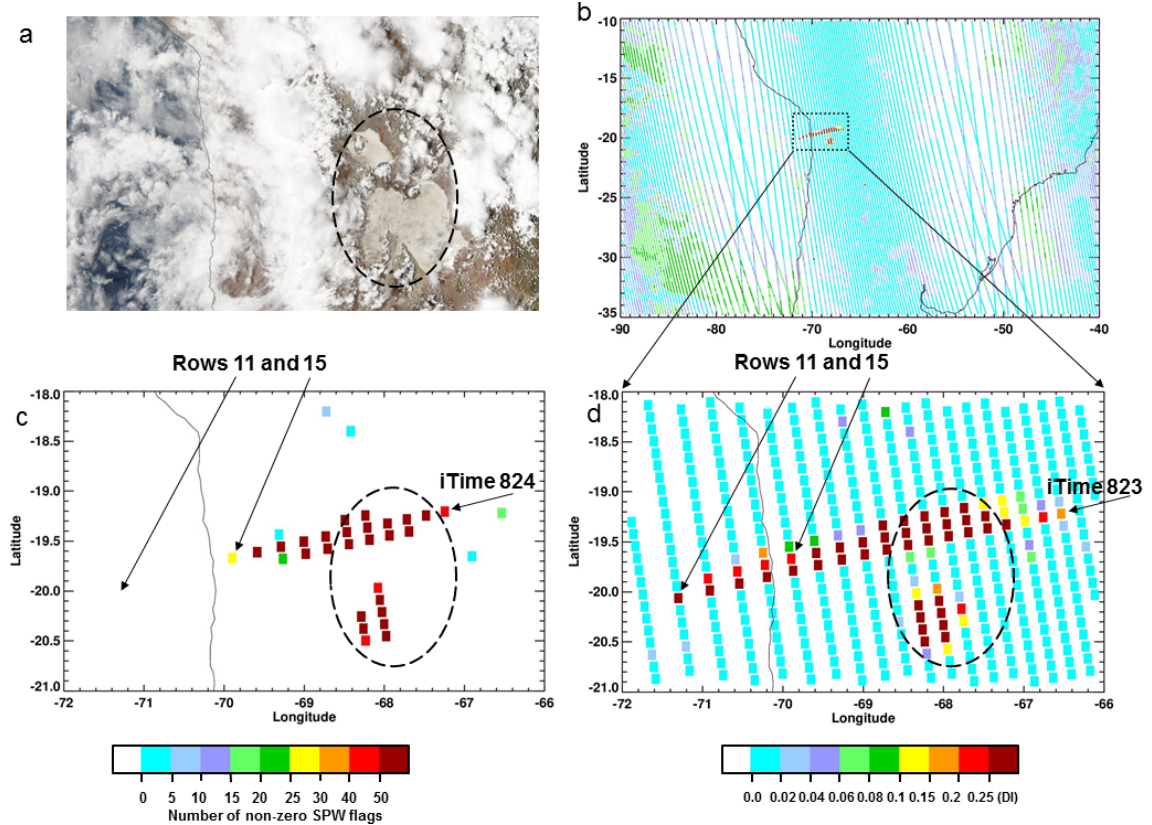
Figure 4. Similar to Fig. 1 but for an area near Salar de Uyuni, 14 January 2006, orbit 7987.